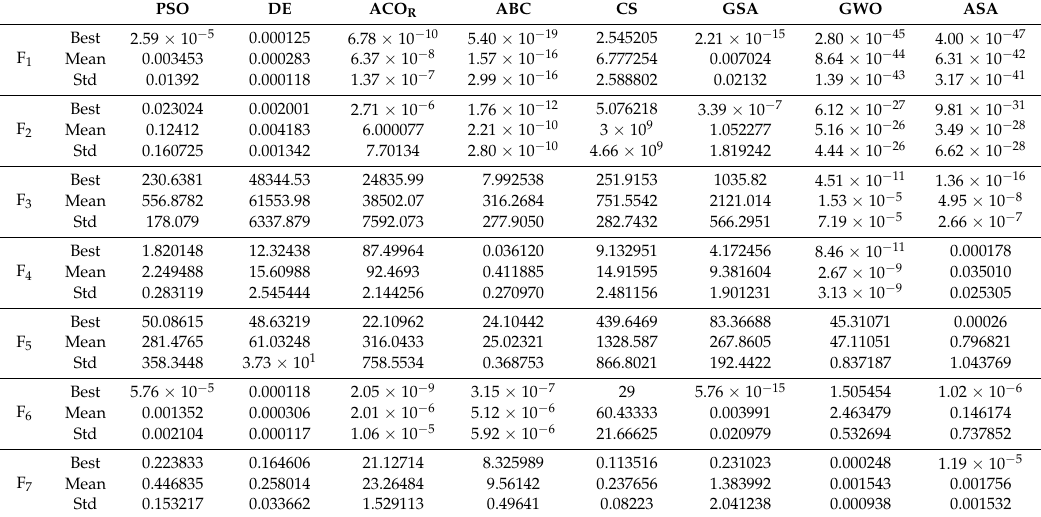
Table 3. Mean, best and standard deviation values of solutions achieved for unimodal test functions taken over 30 runs.